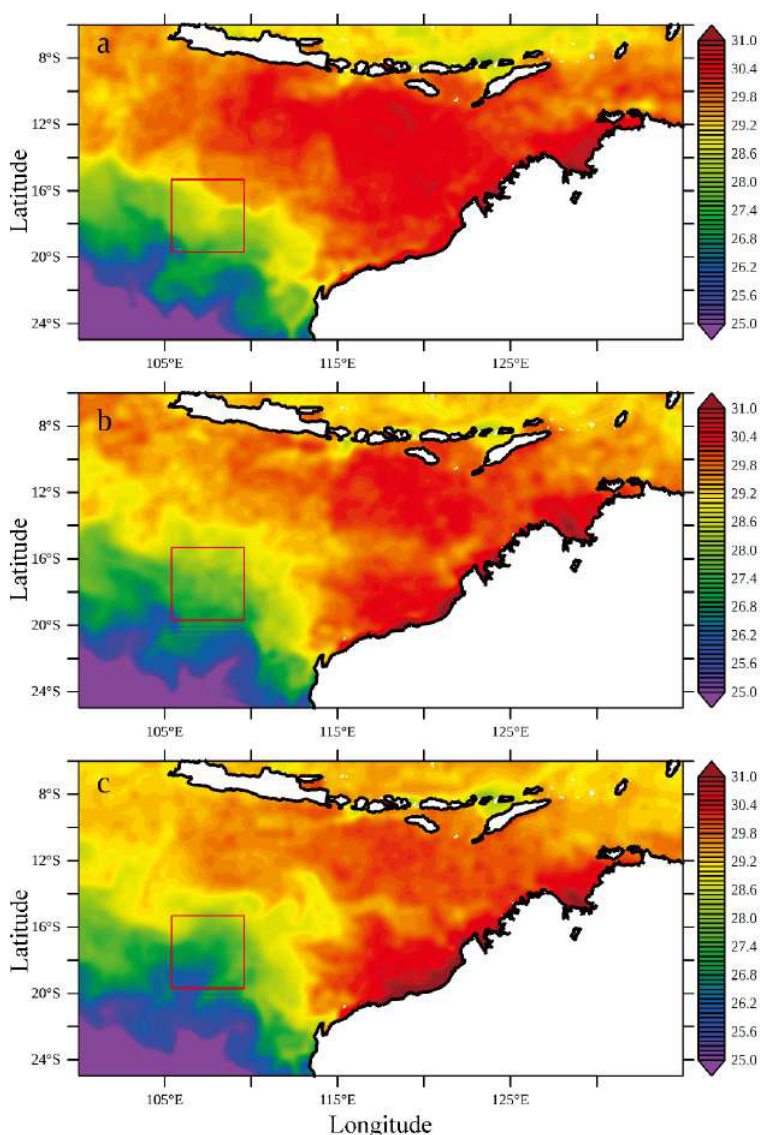
Fig. 6: Distribution of SST (color in °C): (a) before Marcus (11-17 March 2018), (b) during Marcus 18-25 March 2018), (c) after Marcus (26-31 March